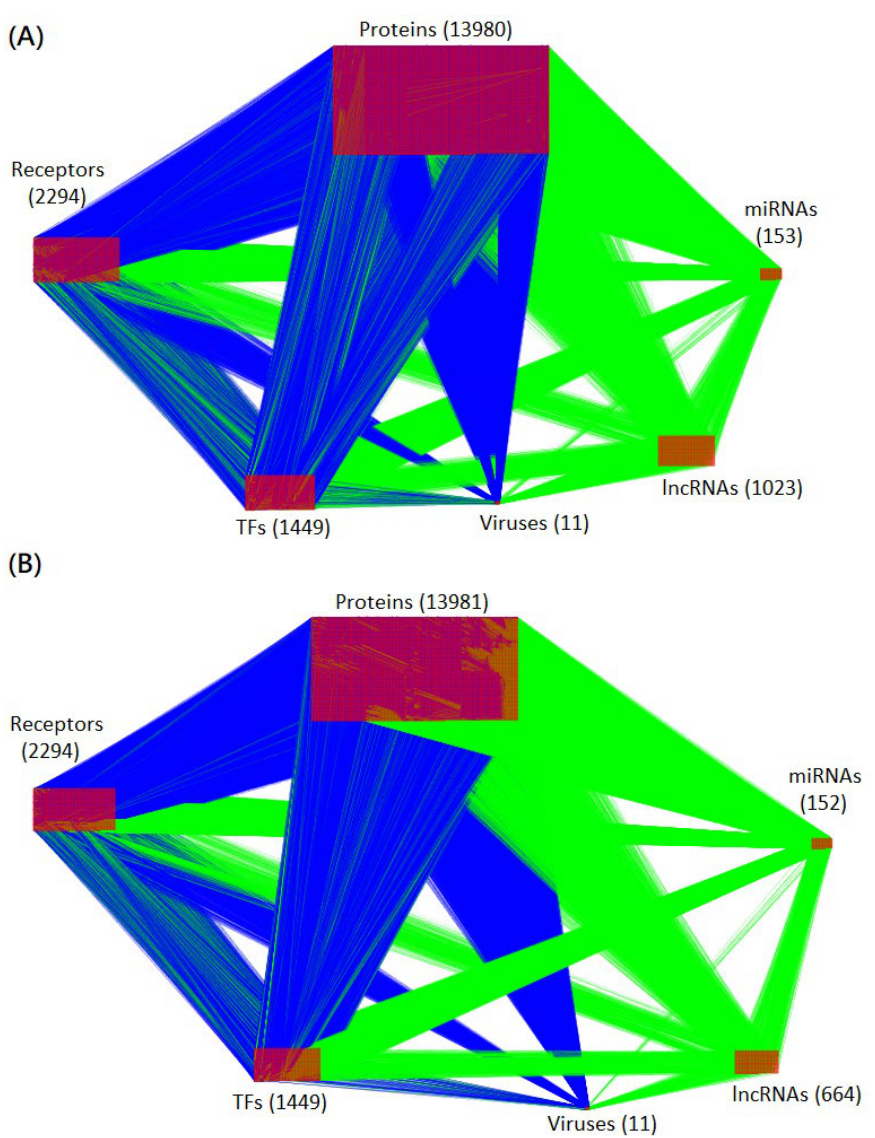
Figure A1. Visualization of real HPI-GWGEN of amplification and saturation infectious stages. The blue and green edges (lines) represent the protein–protein interactions and gene regulations, respectively. The numbers of each type of node (protein, receptor, transcription factor, miRNA, lncRNA, and virus) are shown in the figure. ( A , B ) are the real HPI-GWGENs at the amplification and saturation infectious stages, respectively.